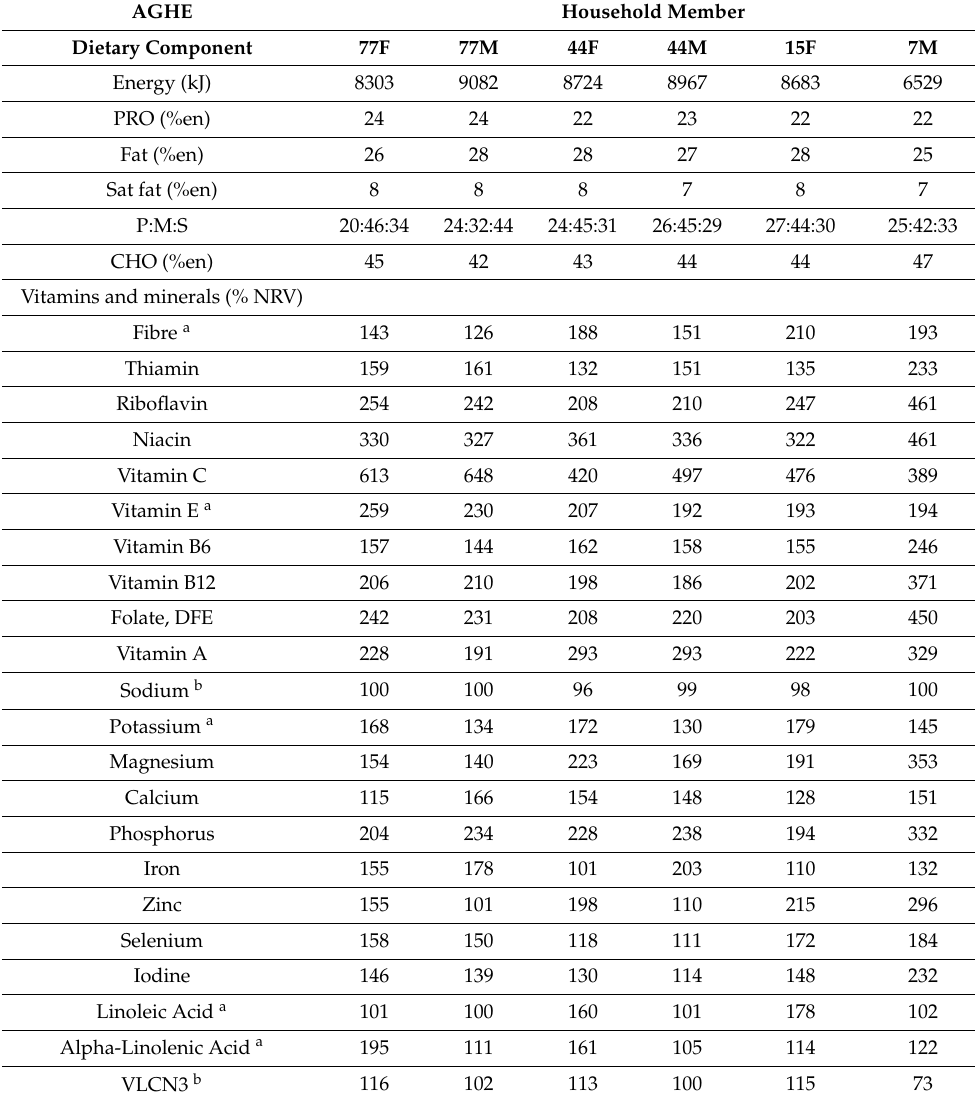
Long-chain omega-3 fatty acids were exceeded by over seven times in the 7-year-old male (731% of the adequate intake), but only met 13% of the upper limit. Table 7. Summary of average daily nutrient intake by household member for the AGHE food basket.